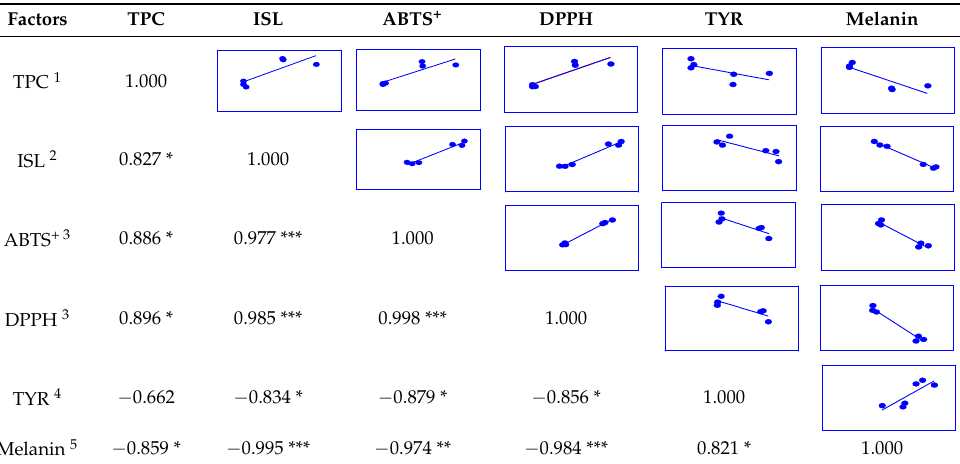
Table 3. Correlation analysis among antioxidant activities, TPC, isoliquiritigenin content and anti- melanogenic activity of licorice extracts.